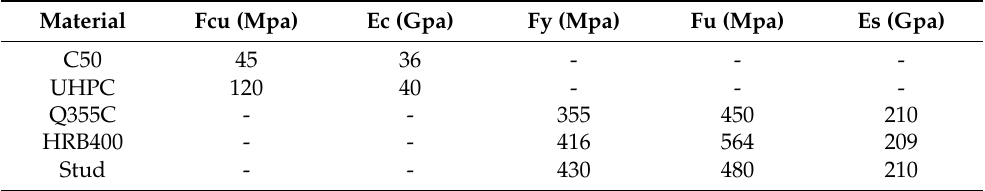
Table 2. Material properties of specimens.